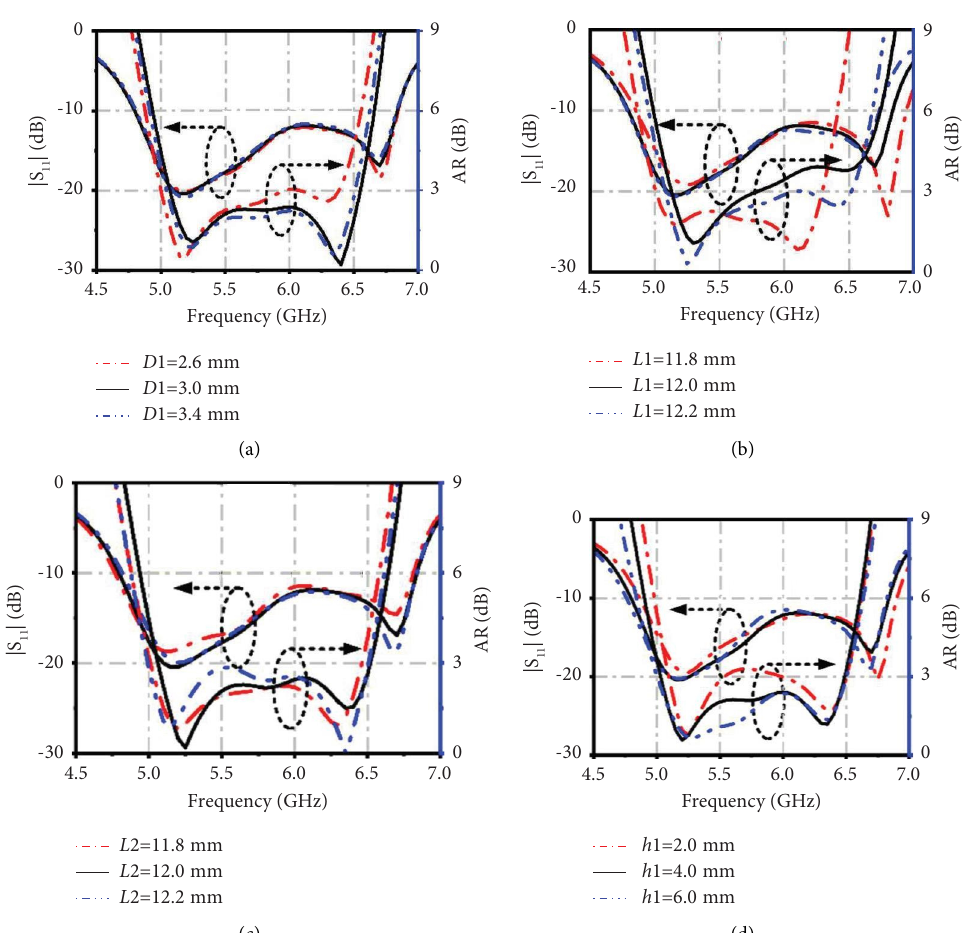
Figure 4: Infuence of changing antenna’s sizes on the | S 11 | values and AR values, (a) D 1, (b) L 1, (c) L 2, and (d) h